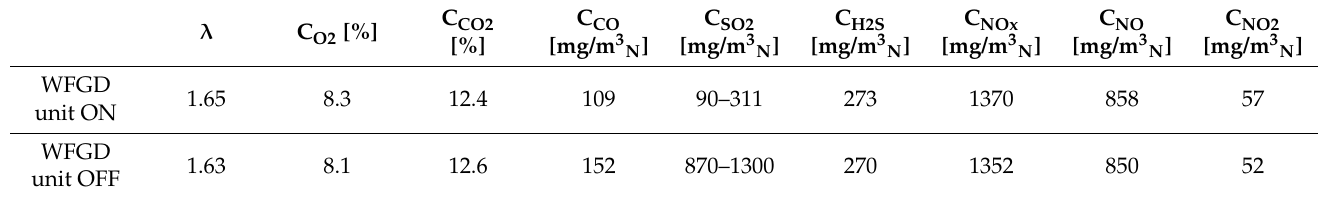
Table 5. Flue gas composition during FSM tests in flue gas.